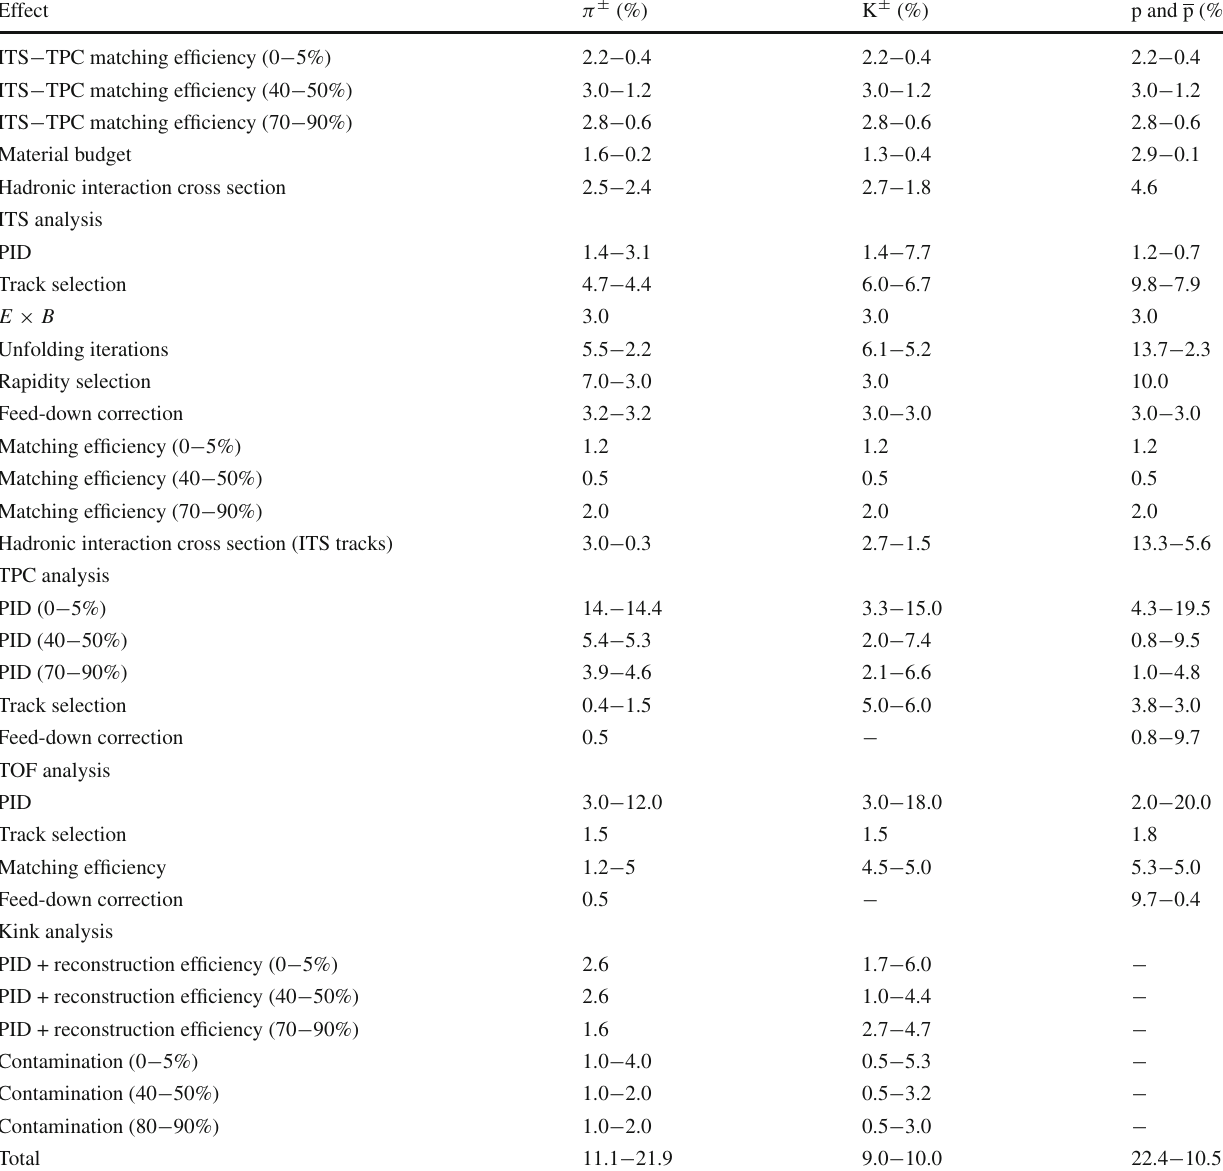
Table 2 Main sources and values of the relative systematic uncertain- ties (expressed in %) of the p T -differential yields of π ± , K ± , p and p obtained in the analysis of Xe–Xe collisions. The first section is com- mon to all the analyses, the analysis specific uncertainties are listed sep- arately. When two values are reported, they correspond to the lowest and highest p T bin respectively, considering the maximum contribu-